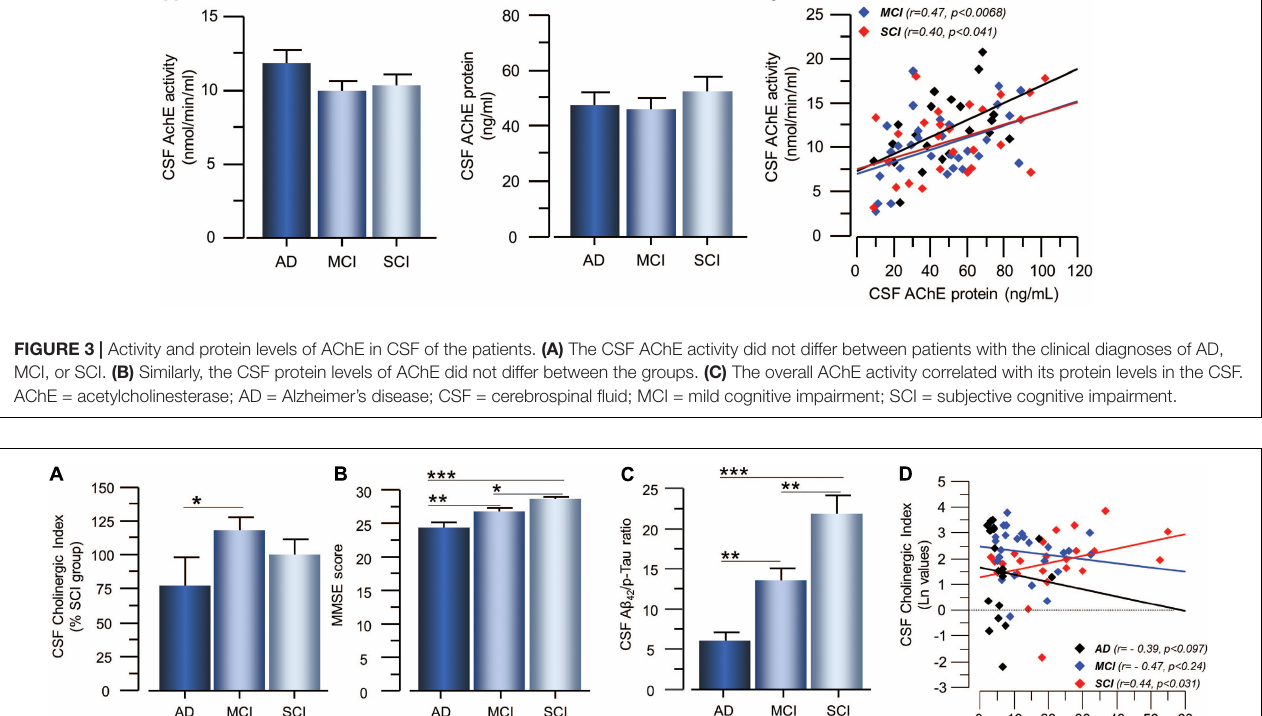
AD ( r = 0.44, p < 0.056) or MCI group ( r = 0.17, p < 0.40). The CSF Cholinergic Index did not correlate with the t-tau levels in any of the groups.